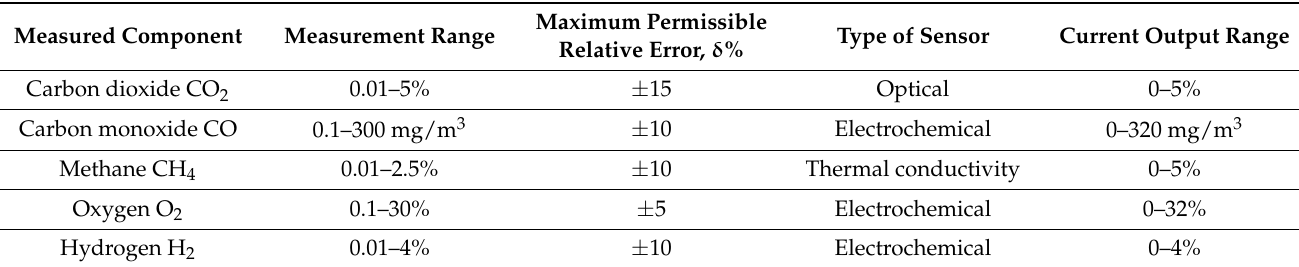
Table 2. Main metrological characteristics of GDS